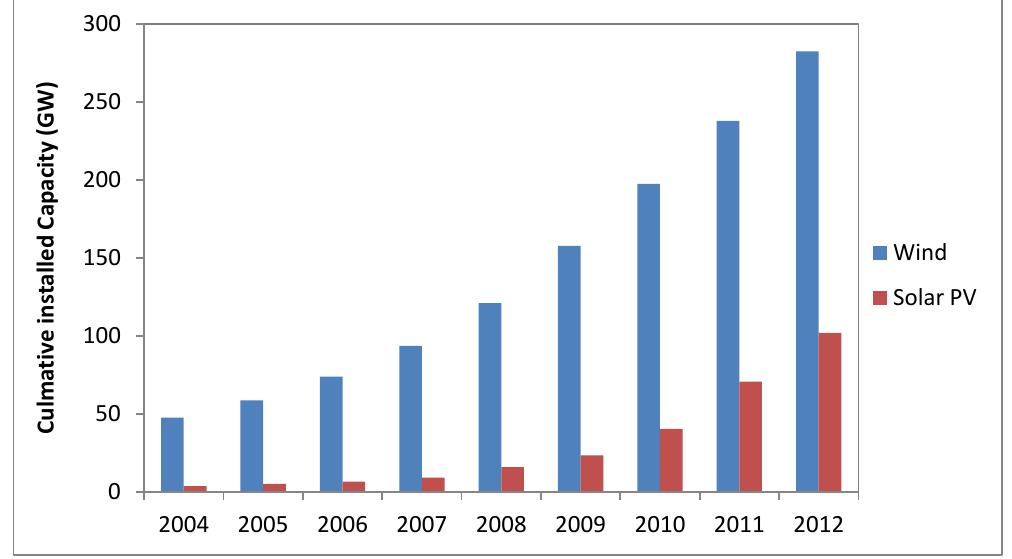
Figure 11. Global cumulative installed capacity of wind and solar PV